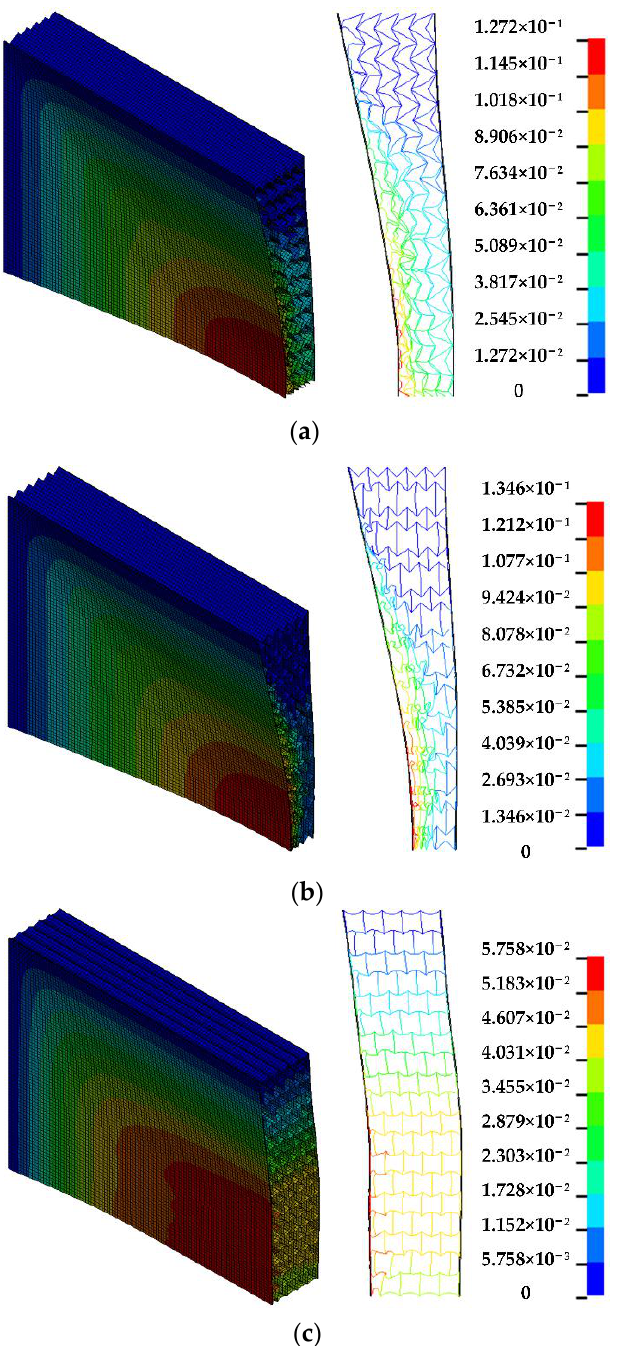
Figure 9. Deformation of sandwich panel with different honeycomb core. ( a ) arrow honeycomb